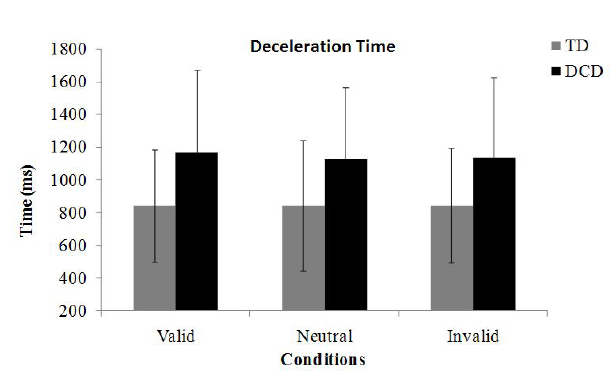
Figure 4. Deceleration time (ms) of children with developmental coordination disorder (DCD) and typically developed (TD) chil- dren under the valid, neutral, and invalid pre-cue information